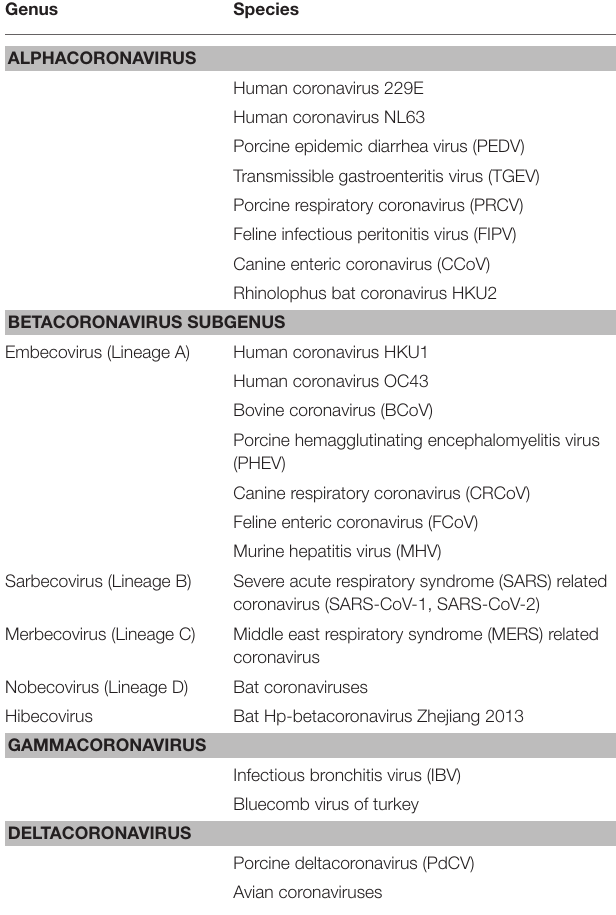
TABLE 2 | Important coronavirus species within individual genera.